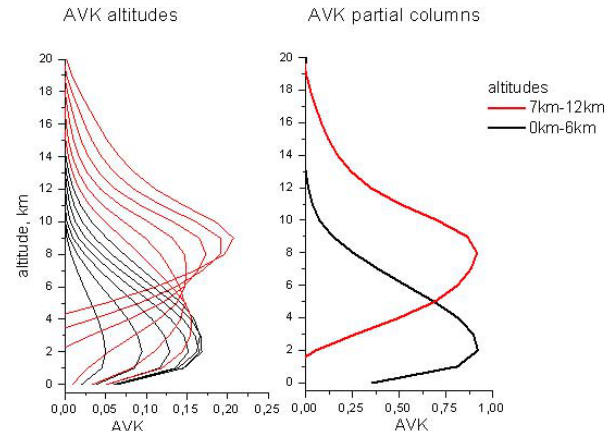
Fig. 2. Typical averaging kernels on the vertical grid used for re- trieval (and model evaluation) and spaced by 1km height vertical layers (left panel) and in partial column space (right panel), the black curve displays the averaging kernel corresponding to the 0– 6km ozone partial columns and the red one shows the same for the 6–12km ozone partial